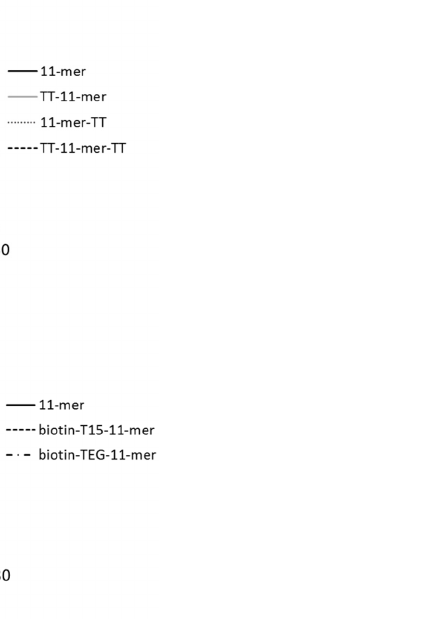
Figure 4. CD spectra of ( a ) the 11-mer and TT derivatives and ( b ) biotinylated derivatives. The spectra were obtained using 10 μ M of each oligonucleotide and represent the average of three